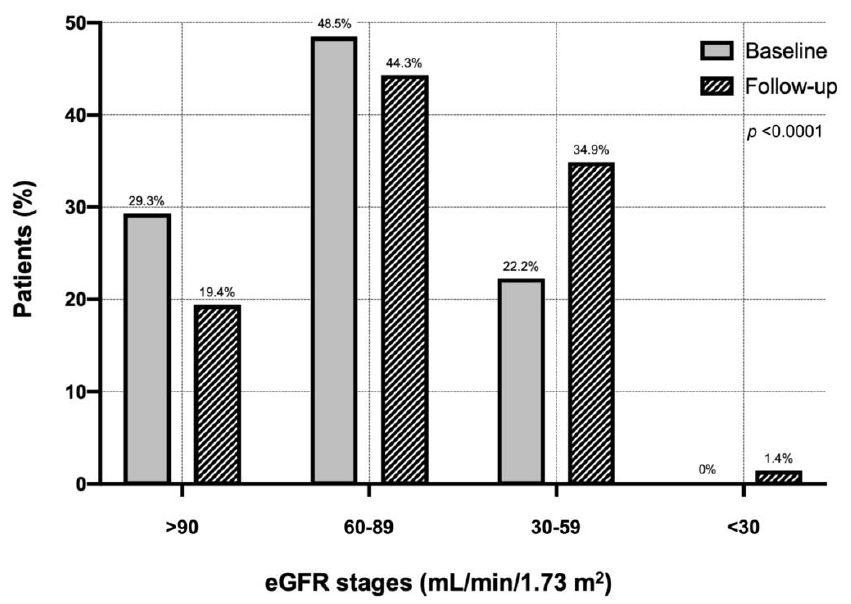
Figure 1. Distribution of eGFR classes in the entire cohort of chronic obstructive pulmonary disease patients at baseline and during follow-up. Abbreviations: eGFR, estimated glomerular filtration rate.